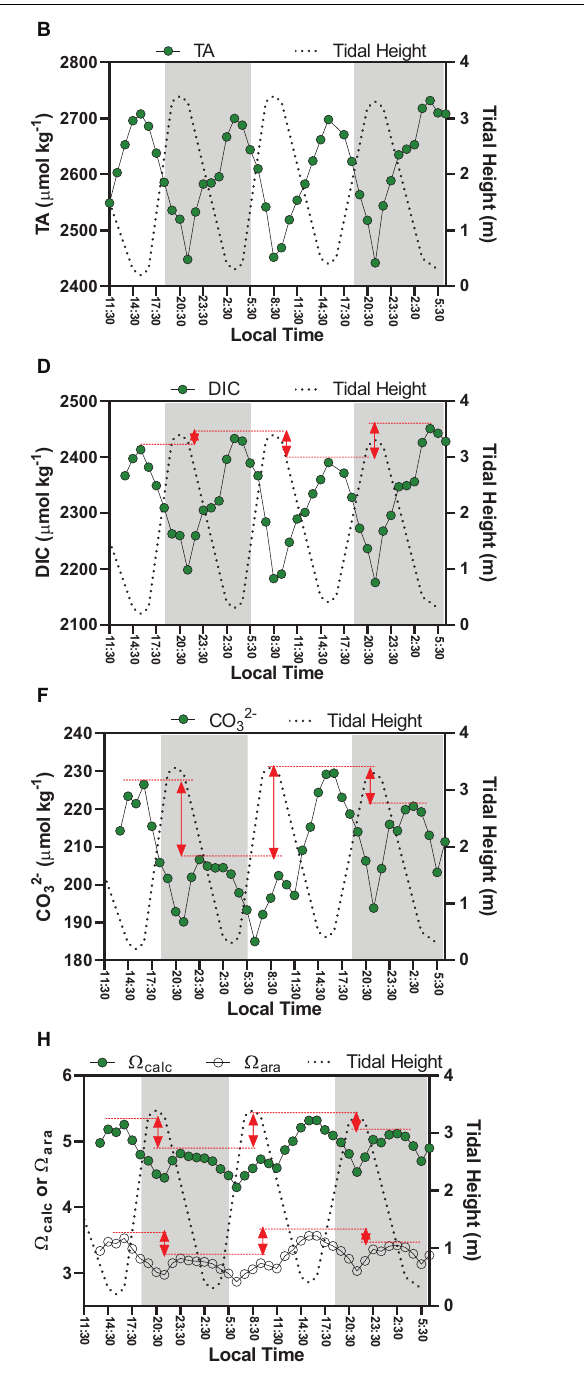
measured during night-time ( p < 0.0001). This diel pattern verified for wind velocities was the same of that verified for the values of gas transfer velocities (k 660 ). The